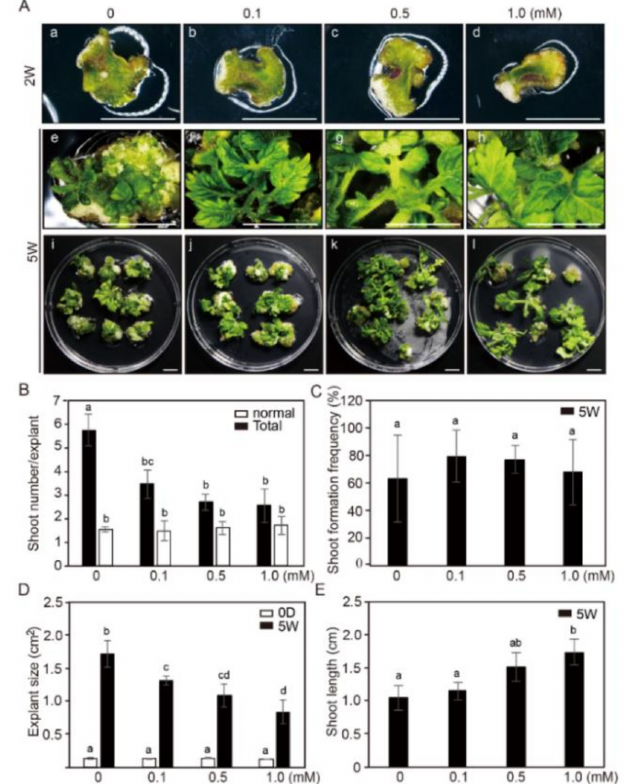
Figure 3. The e ff ect of sodium butyrate (NaB) on adventitious shoot formation in cotyledon explants of tomato. ( A ) Explant growth and adventitious shoot formation in the shoot induction medium (SIM) containing 0, 0.1, 0.5, and 1.0 mM of NaB after 2 (a–d) and 5 (e–l) weeks of culture. Scale bars = 1 cm. The shoot numbers per cotyledon explant ( B ), the frequency of adventitious shoot formation ( C ), the size of tomato cotyledon explants ( D ), and the shoot length in cotyledon explants ( E ) in SIM-containing 0, 0.1, 0.5, and 1.0 mM of NaB. Three independent experiments were performed on 81 explants. Error bars represent SD (N = 81). Di ff erent letters on the bars indicate significant di ff erences between each treatment (ANOVA followed by a Tukey’s test, p < 0.05). D = day; W =